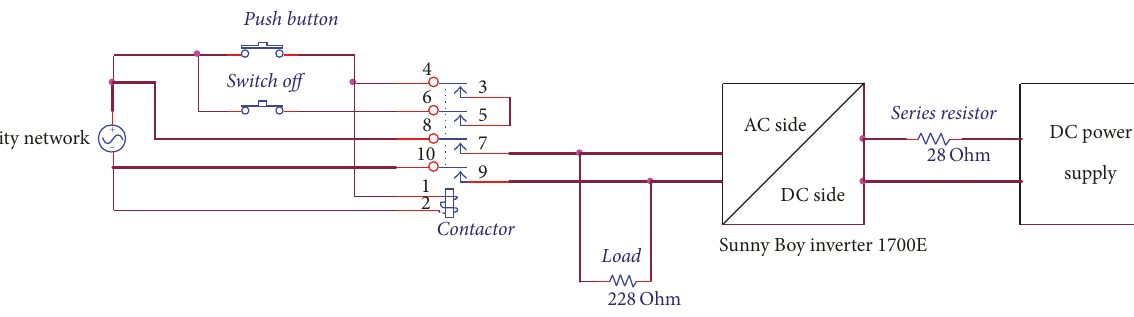
Figure 8: Circuit diagram of the SB 1700E inverter connected in parallel to grid and load 228 Ω